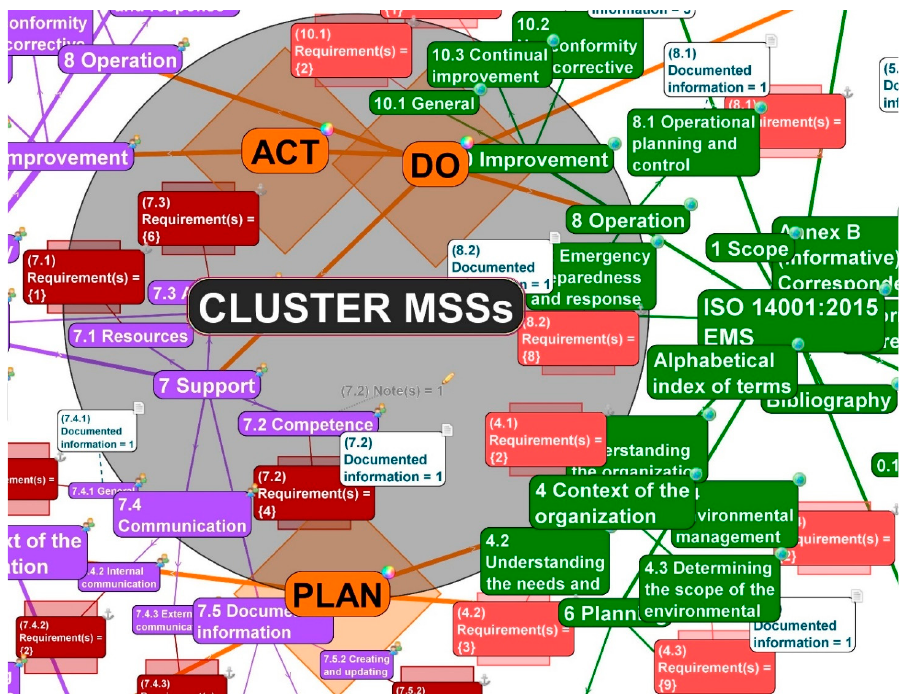
Figure 3. Requirements and documented information of ISO 14001 EMS and ISO 45001 OHSMS, both MSSs with their connections, in the cut-out (source: